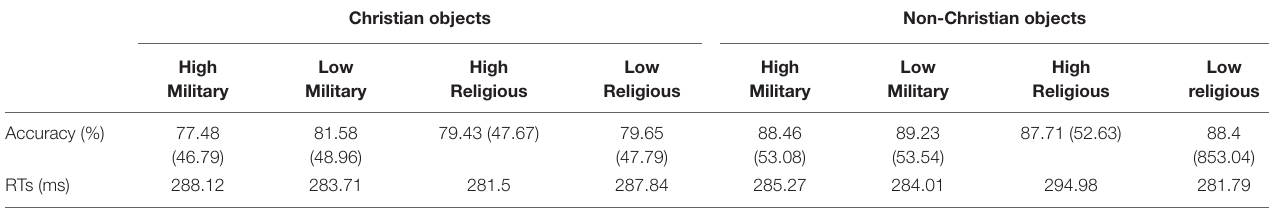
TABLE 1 | Mean percentage of accuracy judgments (with mean values in parenthesis) and reaction times (RTs) during the categorization task for all conditions.